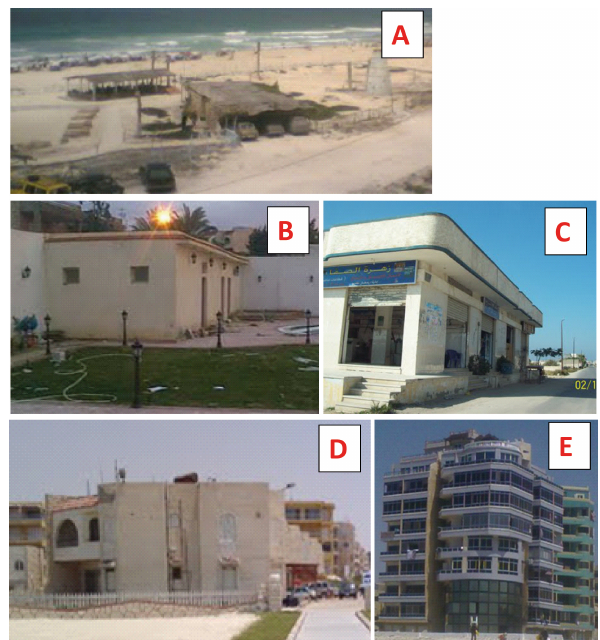
Figure 21. Typical constructions of classes from A to E in Alexan- dria (pictures from Google Earth database).